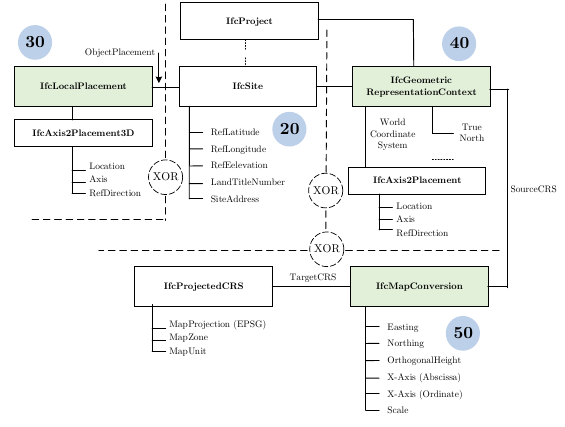
Figure 5. With IfcTerrain the DTM may be georeferenced on LoGeoRef 30, 40 or 50 (Clemen and Görne,